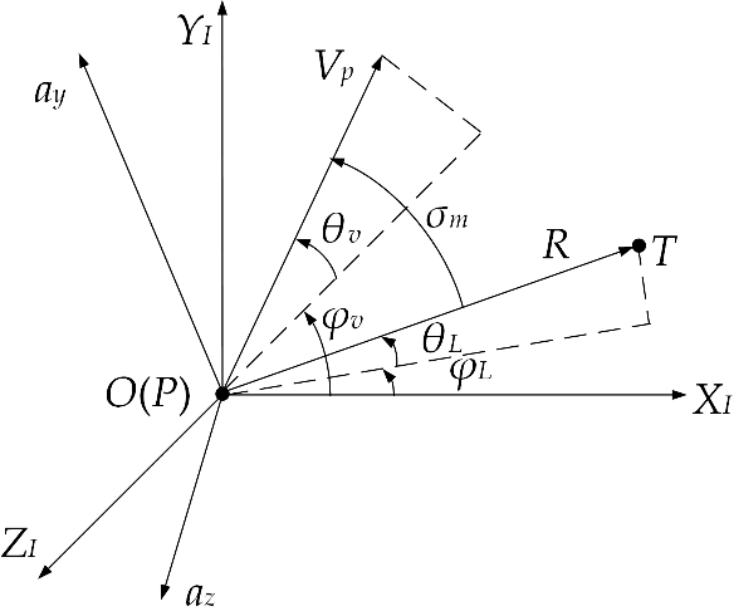
Figure 1. Three-dimensional homing engagement geometry.